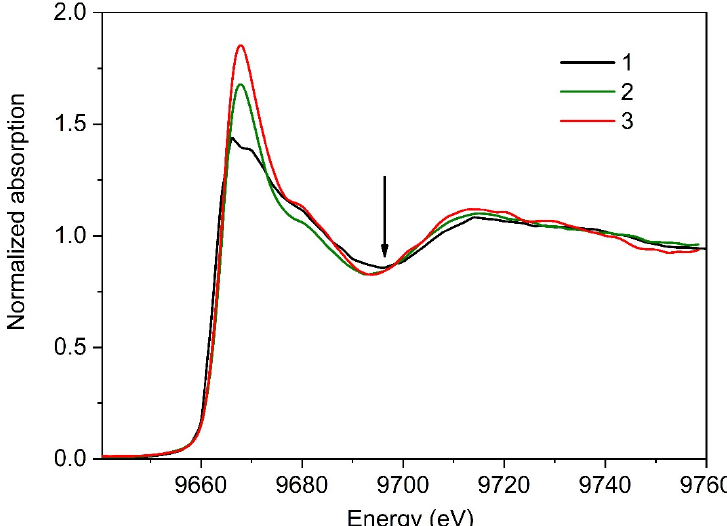
Figure 4. Zn K-edge XANES spectra for the parkin protein layer adsorbed at liquid interface, collected under mild conditions of measurements (Curve 1) and under high X-ray radiation load (Curves 2 and 3).